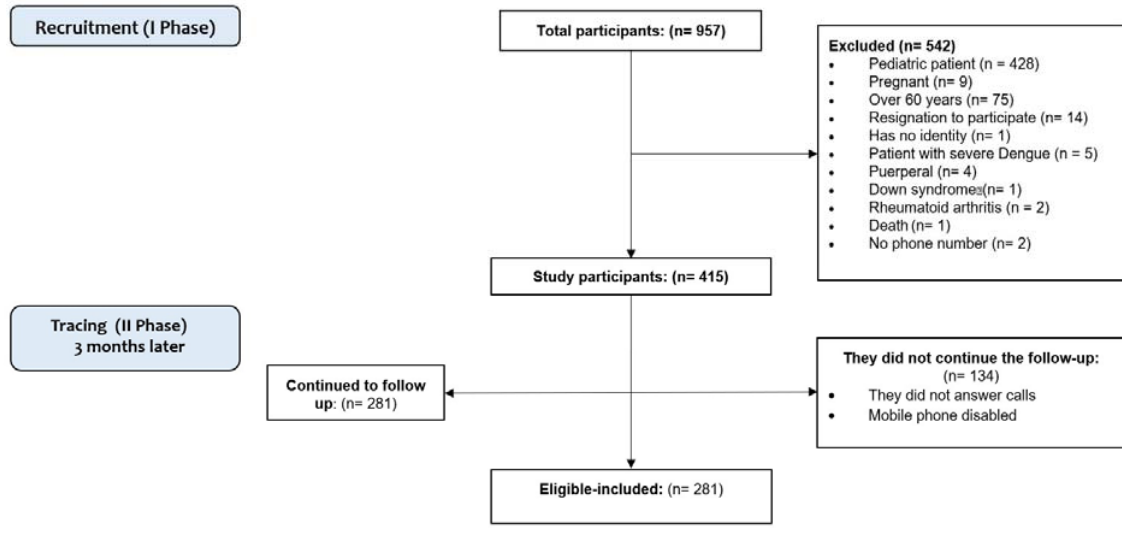
Figure 1. Flow chart of the patients included and excluded.